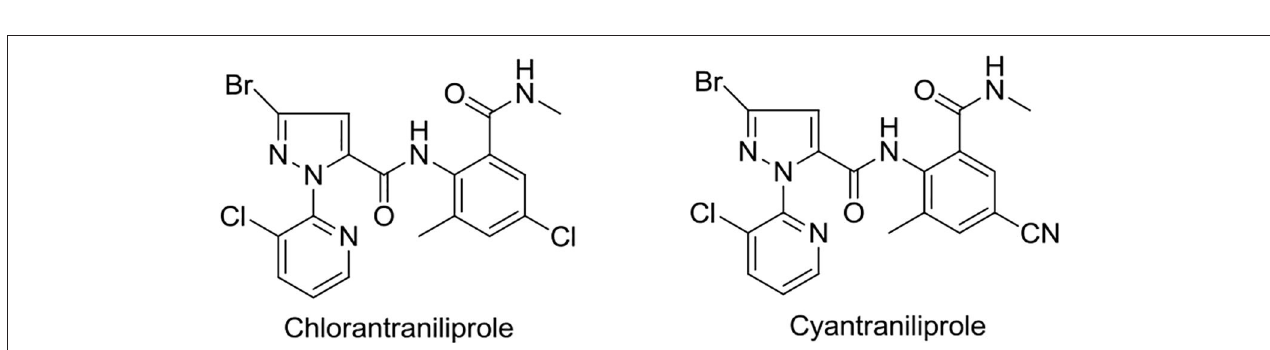
FIGURE 1 | The structures of the pyrimidine derivatives containing 1,3,4-oxadiazole (A,E) , 1,3,4-thiadiazole (B,E) , 1,2,4-triazole (C) or amide (D) moiety reported by our research group.